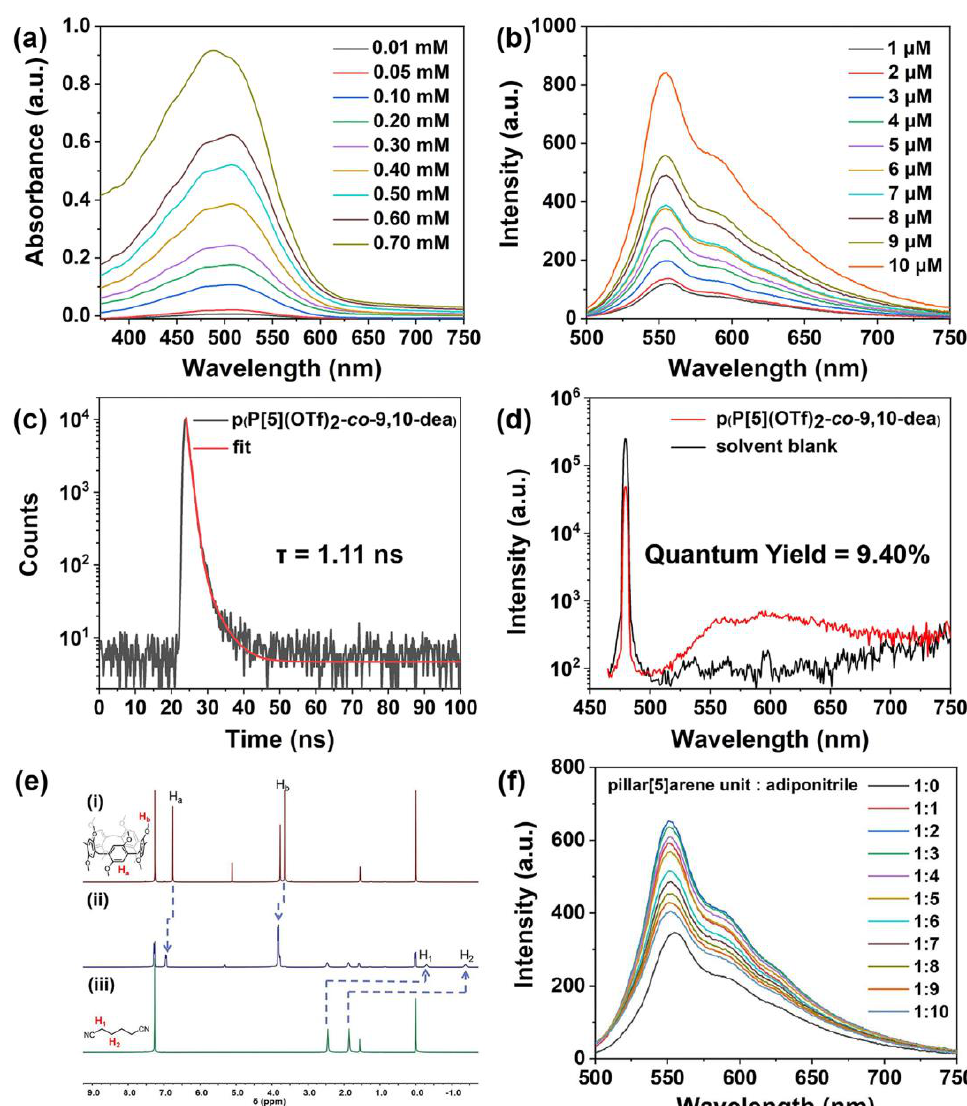
Figure 3. ( a ) The UV-vis absorption spectra and ( b ) fluorescence spectra of p(P[5](OTf) 2